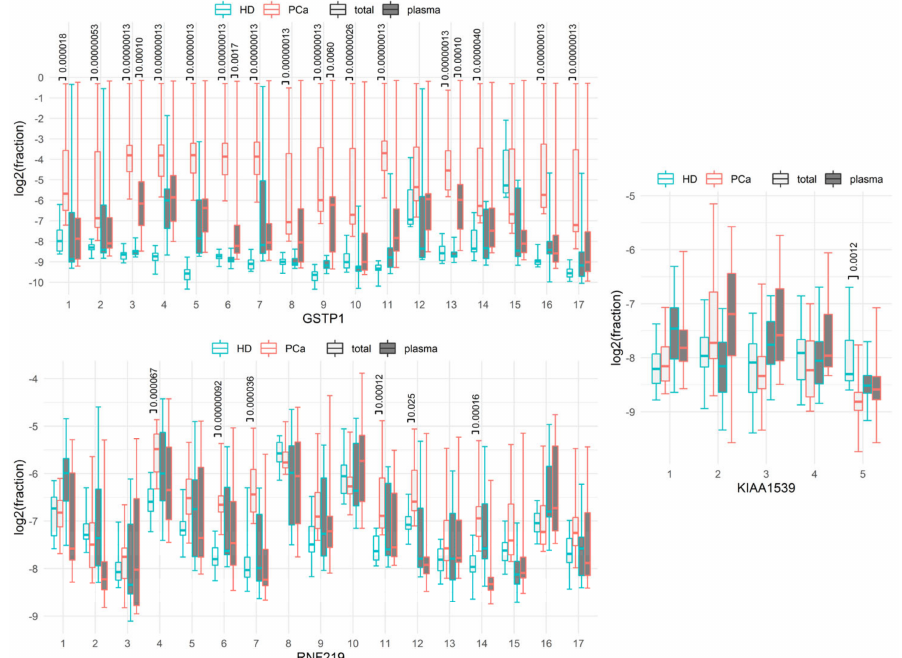
Figure 1. Individual CpG dinucleotides methylation level at different positions of the studied loci. Methylation level of cfDNA in accordance to [21] presented as grey boxplots. HD and PCa groups are marked in blue and red, correspondingly. The boxes depict medians with the 1st and 3rd quartiles. The whiskers depict minimums and maximums. The adjusted p-values are reported for the differences (i.e., the p -values multiplied by 1167), where the adjusted p -values are